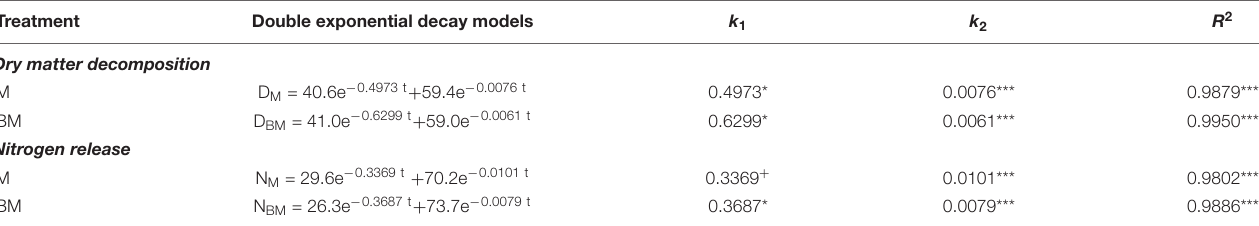
TABLE 1 | The rate constants ( k ) of mass decomposition and N release for leguminous cover crop residue with or without rice straw biochar estimated by using a double exponential model. Treatment